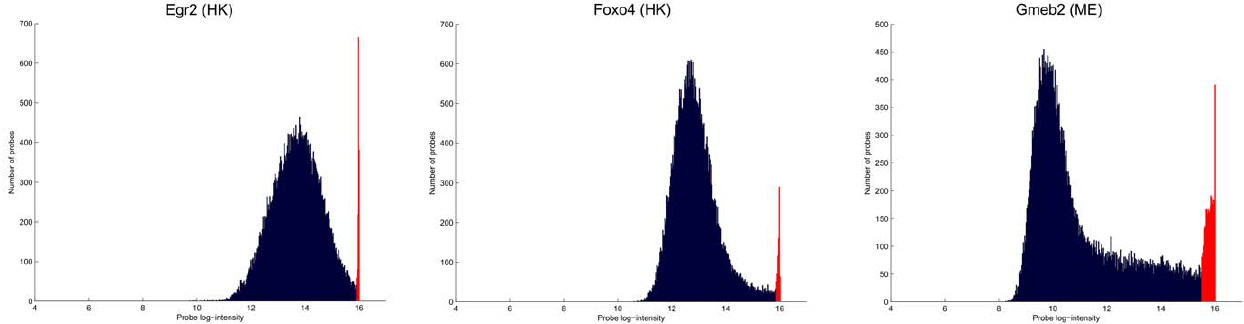
Figure 7. Examples of highly saturated PBM samples. Each figure shows a probe log-intensity histogram where saturated probes are highlighted in red